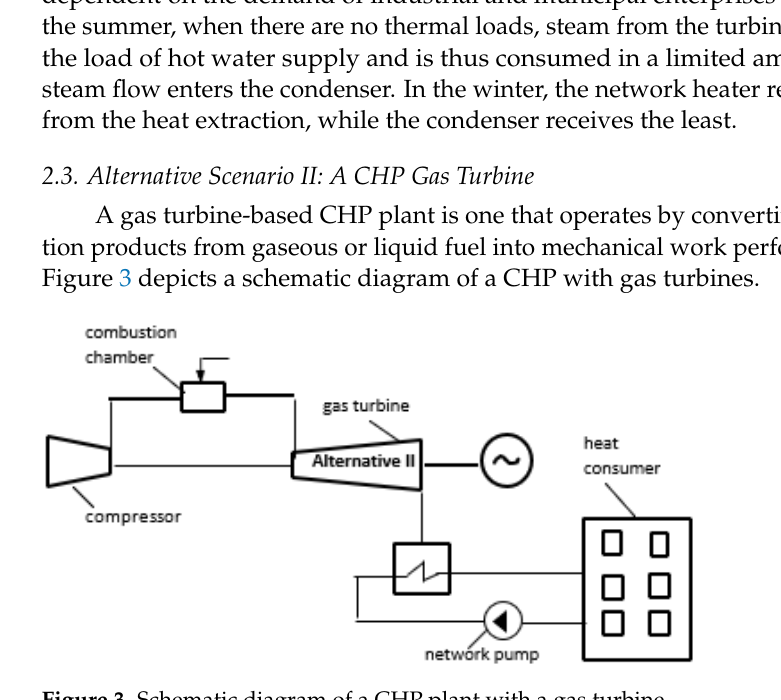
Figure 3. Schematic diagram of a CHP plant with a gas turbine.